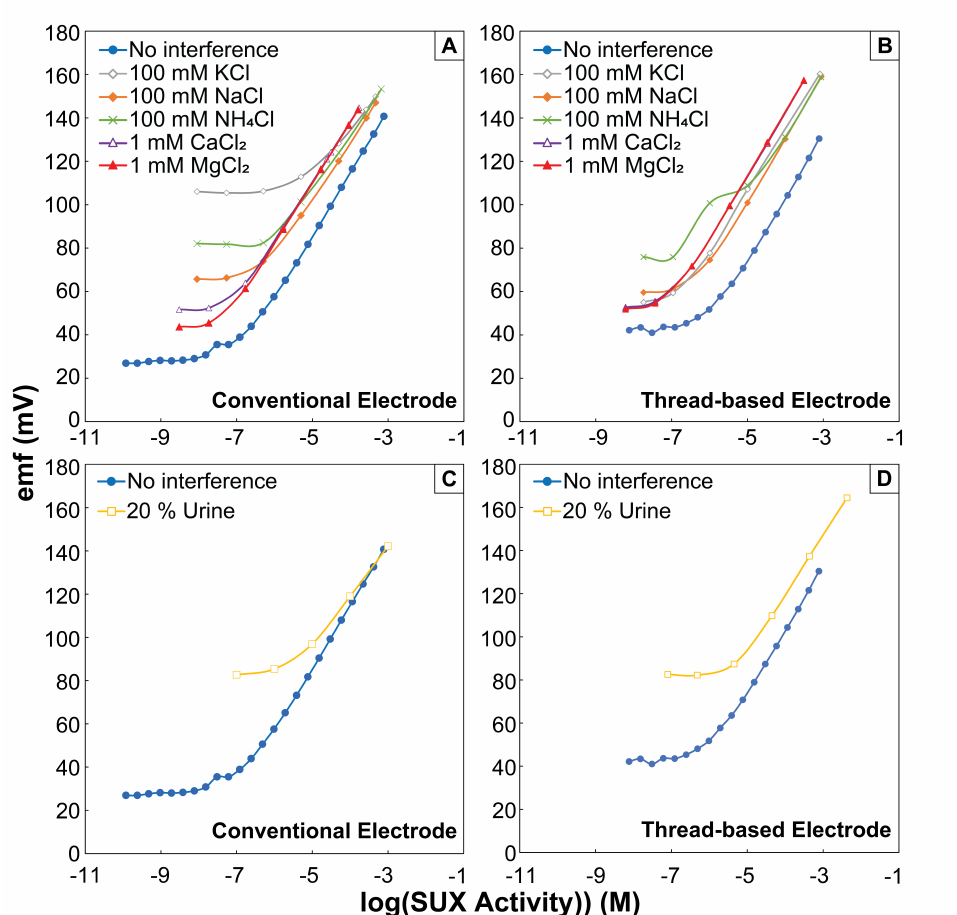
Figure 3. The response curves for ( A , C ) conventional ISEs and ( B , D ) the thread-based ISEs in the presence of a fixed concentration of interfering cations. ( A , B ) The interfering inorganic salts caused LODs to increase in both conventional ISE and thread-based ISE systems. ( C , D ) Unknown urine content caused larger increases in LOD in both systems.